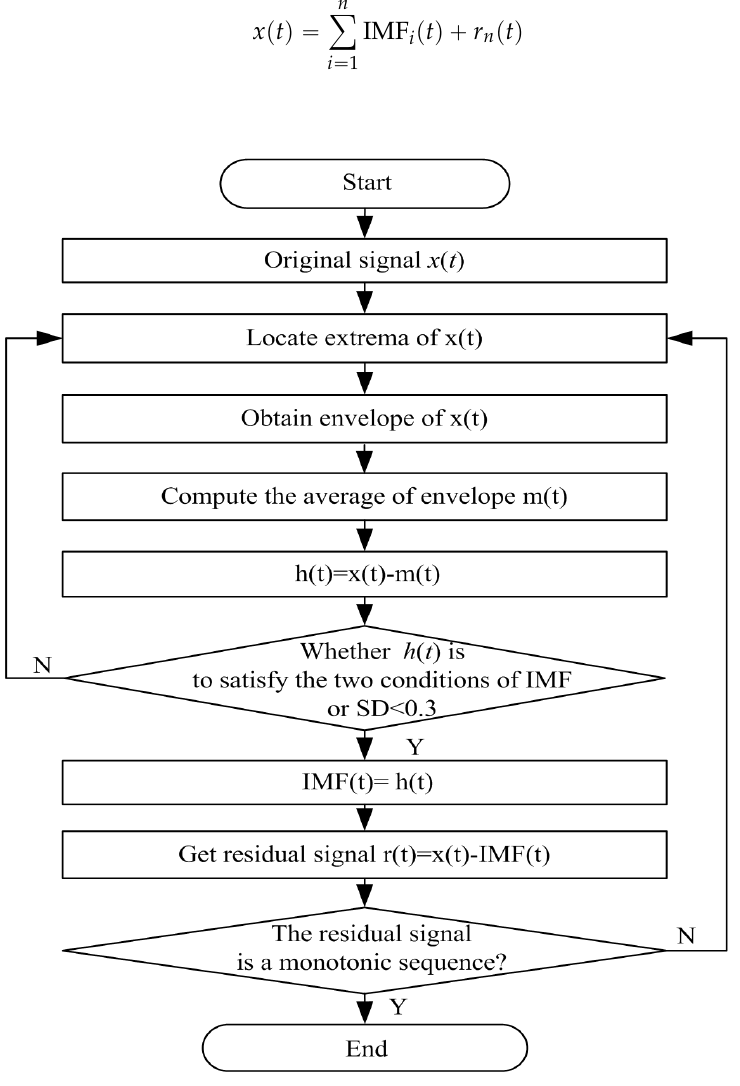
Figure 2. The flow chart of empirical mode decomposition algorithm.